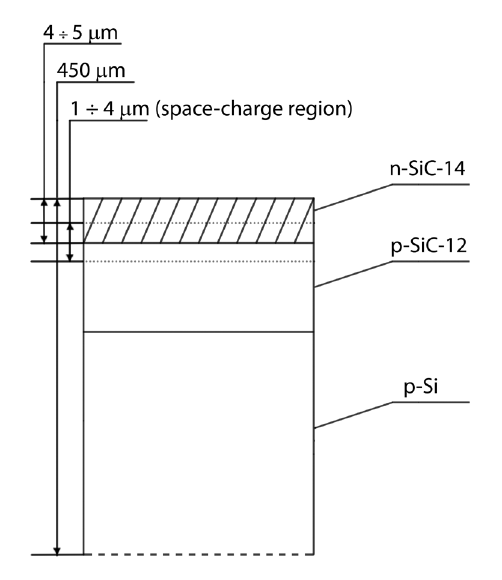
Figure 1. The structure of